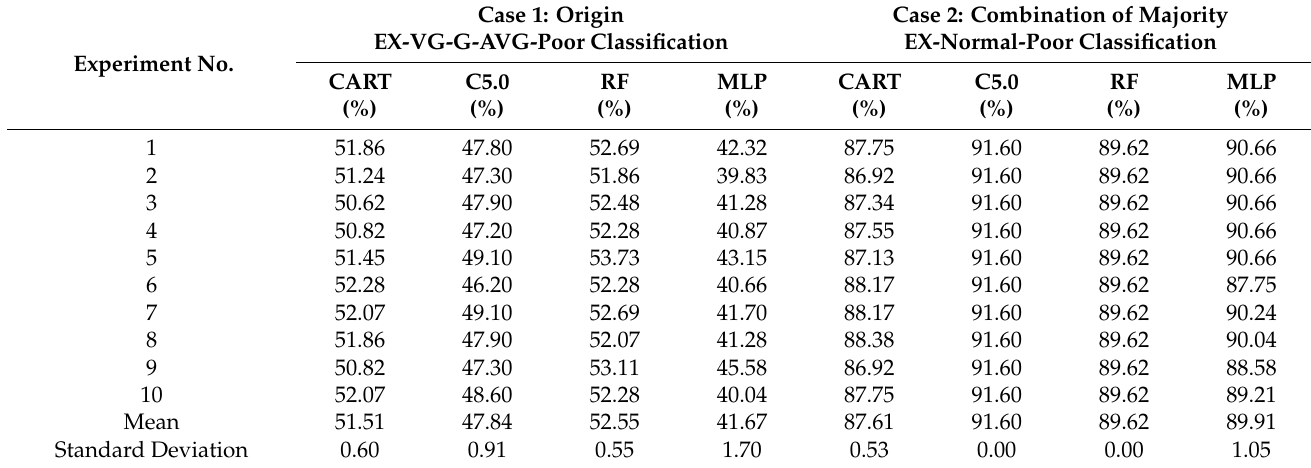
Table 3. Results of Case 1 and Case 2.